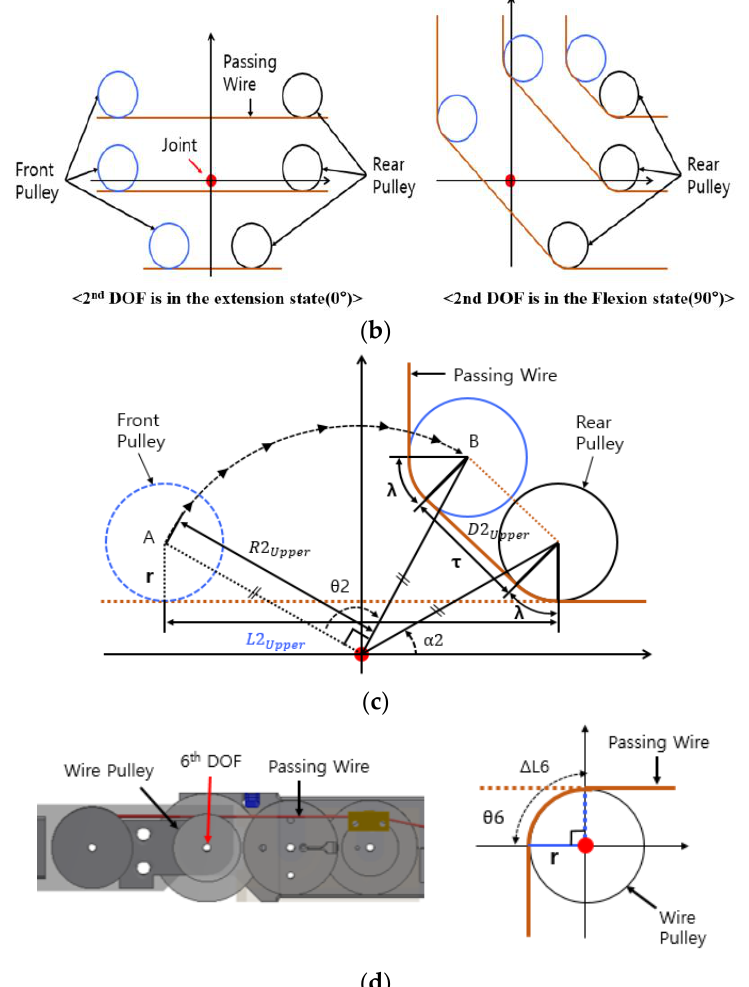
Figure 8. Structure of the 2nd DOF: ( a ) DOF layout ( b ) changes in the passing wire when the 2nd DOF rotates by 90° ( c ) example of the 2nd DOF rotating 90° to the right ( d ) 6th DOF and an example of rotating 90°.